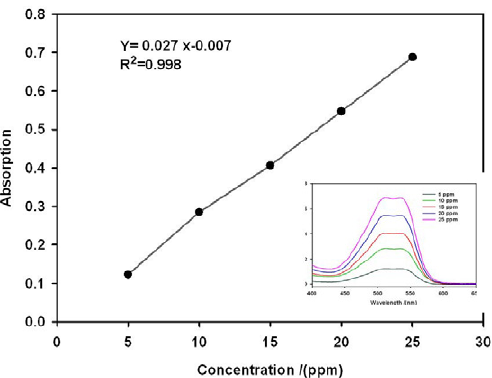
Fig. 9. Absorption spectra of the Reactive Red 4 solution with initial concentration of 10.3 mg/L under UV irradiation and using iron oxide as